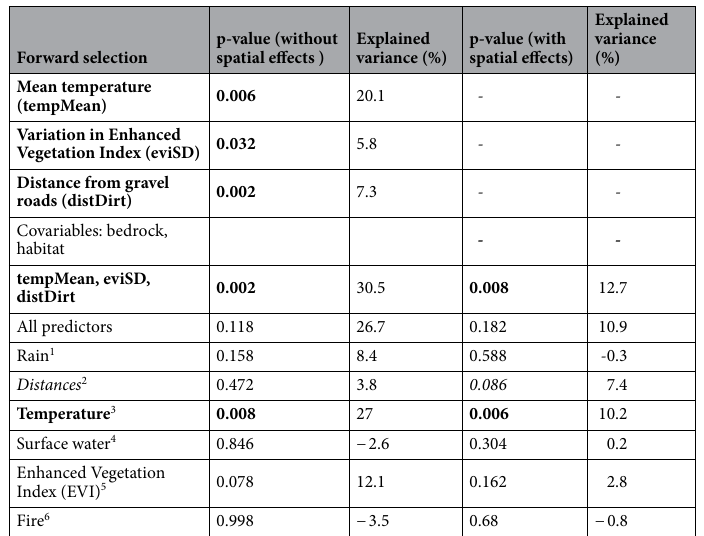
Table 3. Results of the ordination models (direct gradient analysis—RDA) exploring and testing the relations between large-scale predictors and plant species richness/cover in the Kruger National Park. In all ordination models, total plant richness, richness of herbs, richness of shrubs, cover of grasses and cover of shrubs were used as the response variables. Spatial effects are represented by the three main principle coordinates (PCO1, PCO2, PCO3). Significant effects are displayed in bold, marginally significant effects in italics. The significance values refer to individual predictors in case of forward selection, and to the significance of all canonical axes in the remaining ordination models. See Supplementary Table 1 for detailed description of variables. 1 Summary effect of rainfall (rainSum, rainMean, rainSD). 2 Summary effect of distance from potential sources of propagules—roads, rivers, rest camps and KNP boundary (DistBnd, distCamp, distTar, distDir, distRiv, distStrm; see Supplementary Table 1). 3 Summary effect of temperature and its variation over time (tempMean, tempSD, tempMin, tempMax). 4 Summary effect of surface water occurrence (waterSum, waterMean, waterSD). 5 Summary effect of Enhanced Vegetation Index (eviSum, eviMean, eviSD). 6 Summary effect of fire (FireSum, FireMean,